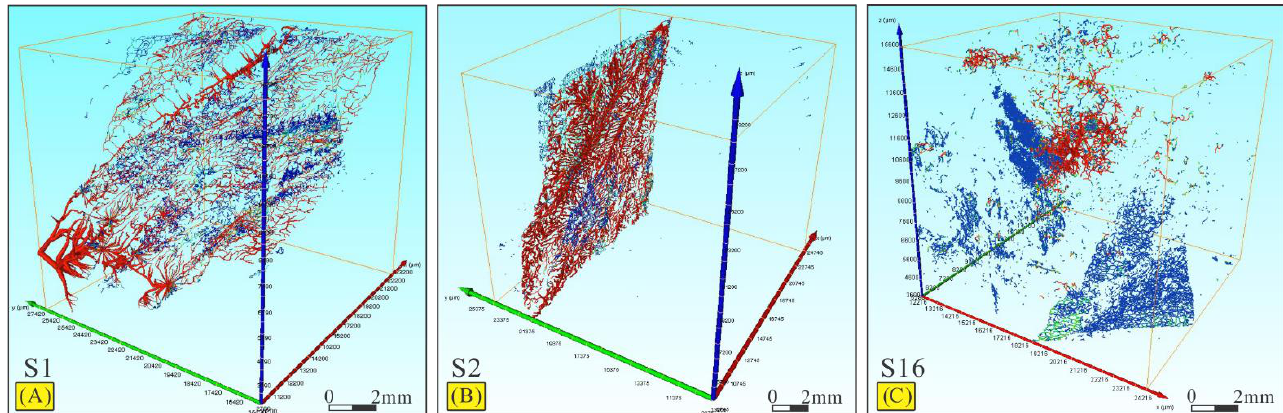
Figure 8. Extracted pores and fractures based on the reconstructed 3D µCT models of Samples 1 ( A ), 2 ( B ), and 16 ( C ). The colors indicate the distribution characteristics of the flow channels in the fractures (red), the connected flow paths (blue), and the void space of rounded pores (green). Different fracture distributions are evident in the images, including single fractures oriented diagonally ( A ) or subparallel ( B ) to the flow direction as well as multiple micro-fractures with a random orientation ( C ).